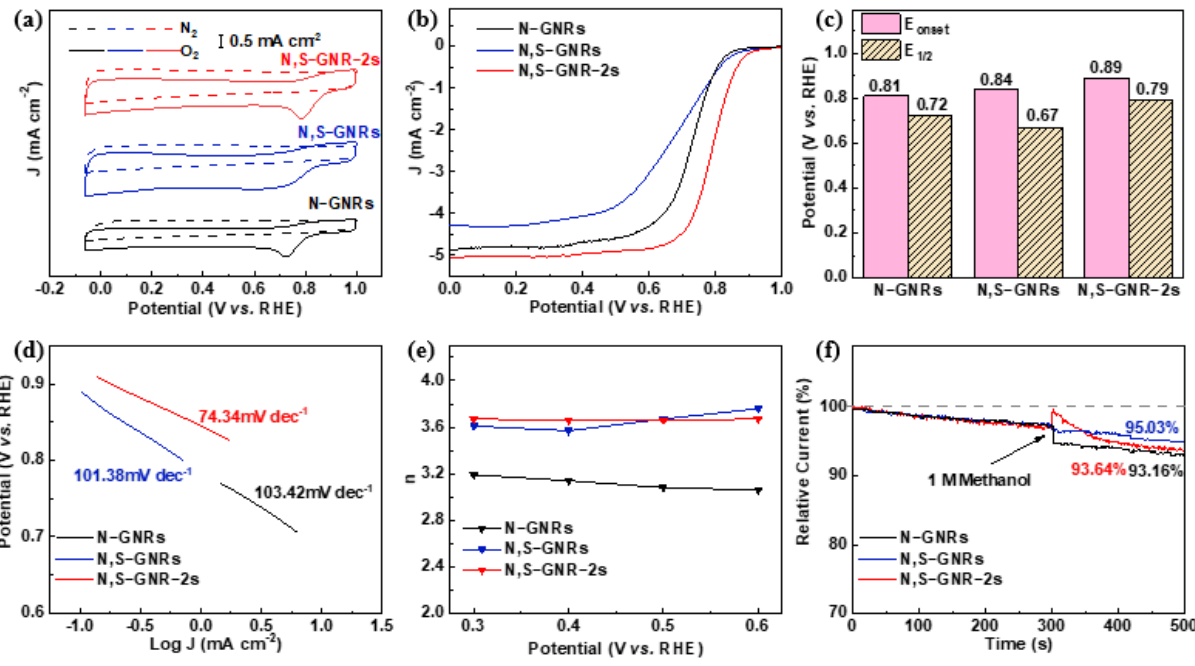
Figure 5. Electrocatalytic property tests of N-GNRs, N, S-GNRs and N, S-GNR-2s. ( a ) The CV test in 0.1 M KOH. ( b ) The RDE test at a rotating speed of 1600 rpm. ( c ) The corresponding values of E onset and E 1/2 . ( d ) The corresponding Tafel plots based on the RDE tests. ( e ) The values of electron transfer number (n) at certain potentials. ( f ) The methanol tolerance test.